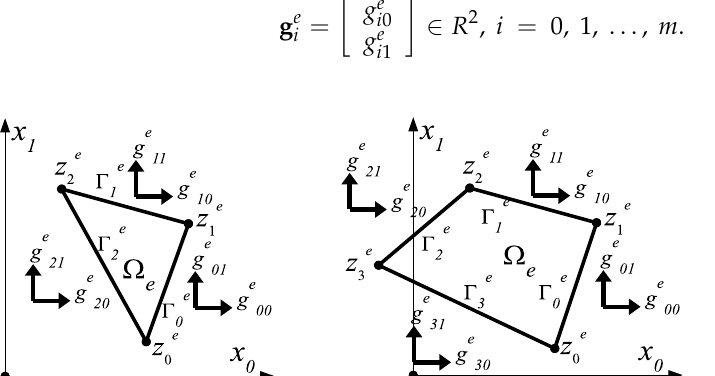
i = 0,1,2 ( ,3 ) of finite i